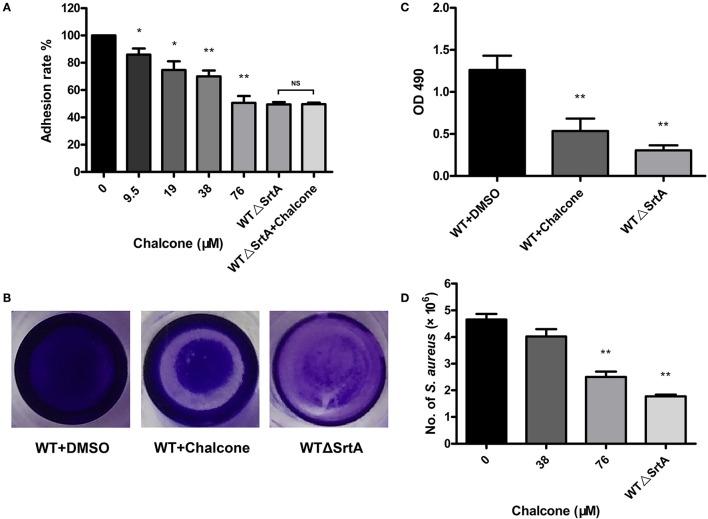
Chalcone reduces the adhesion of S. aureus to Fn, biofilm formation and S. aureus invasion. (A) Adhesion rate of S. aureus to Fn in the presence of different concentrations of chalcone. The WTΔSrtA strain was incubated with 76 μM chalcone. (B) Photographs of biofilms grown in 96-well flat-bottom polystyrene microtiter plates. (C) Quantification of the biofilm mass. (D) Chalcone weakened S. aureus invasion. Bacteria and J774 cells were cultured with chalcone at different concentrations at 37°C for 1 h, followed by gentamicin addition and incubation at 37°C for 30 min, after which number of intracellular bacteria was determined. Three independent experiments were performed to obtain stable results. *P < 0.05 vs. the WT group, **P < 0.01 vs. the WT group and NS represents no significance.